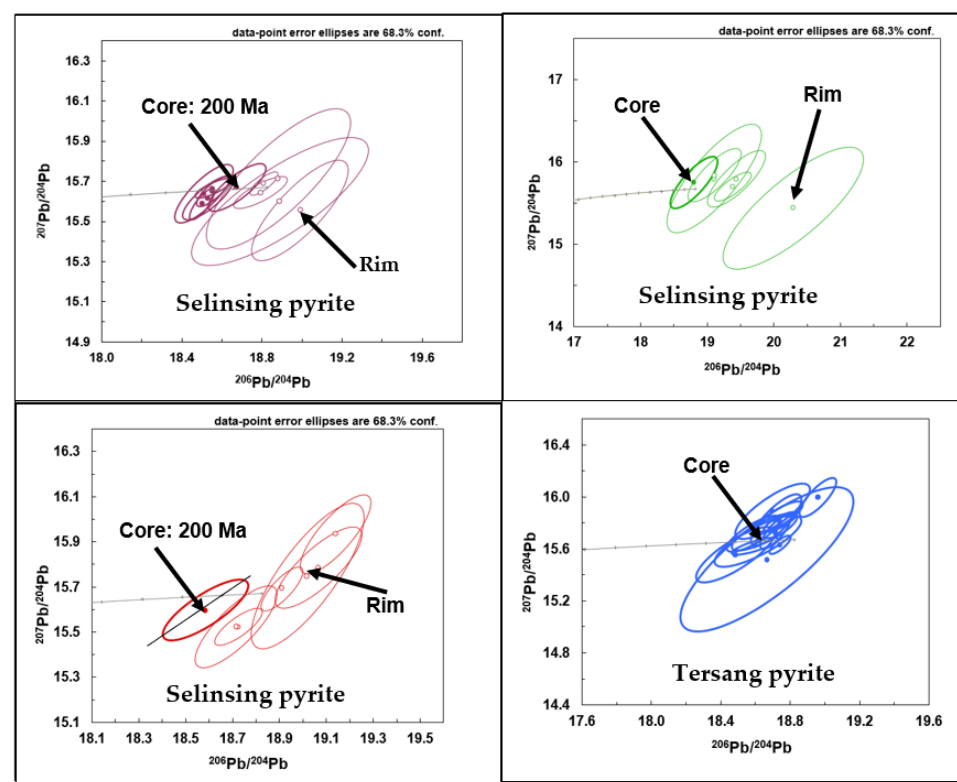
Figure 13. Laser ablation ICP ‐ MS analysis of 206 Pb/ 204 Pb and 207 Pb/ 204 Pb in pyrite from the Selinsing and Tersang gold deposits. The 200 Ma Pb ‐ Pb model age corresponds to the pyrite core zone for pyrite crystals analyzed for both the Tersang and Selinsing gold deposits .